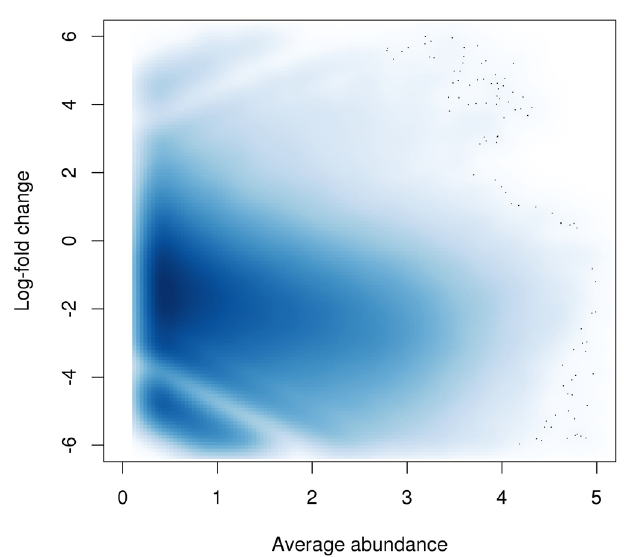
Figure 3. Abundance-dependent trend in the log-fold change between two H3K9ac libraries (mature B over pro-B), across all windows retained after